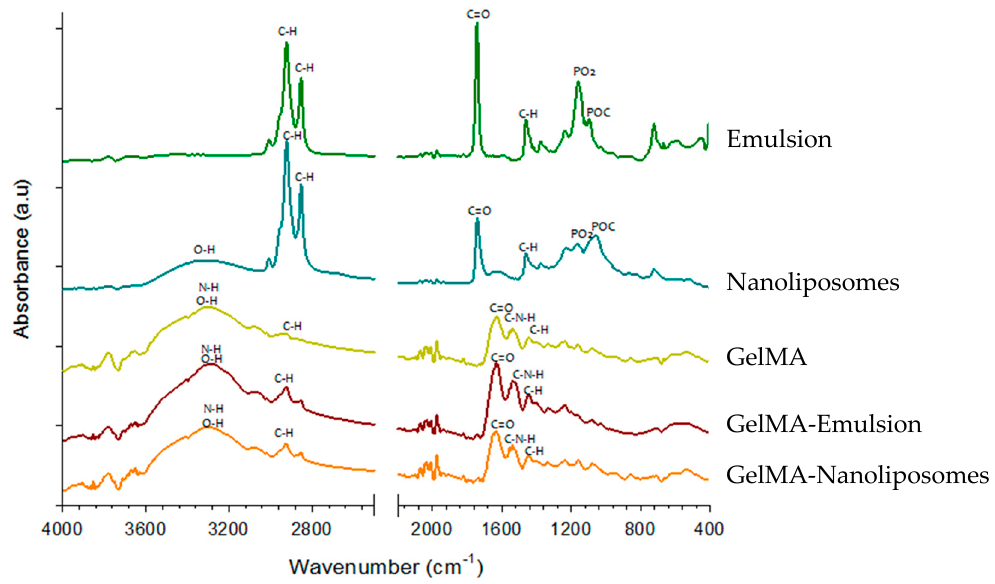
Figure 2. Fourier-transform infrared spectroscopy (FTIR) spectra of Emulsion, Nanoliposomes, GelMA, GelMA-Emulsion, and GelMA-Nanoliposomes. a.u., arbitrary unit.